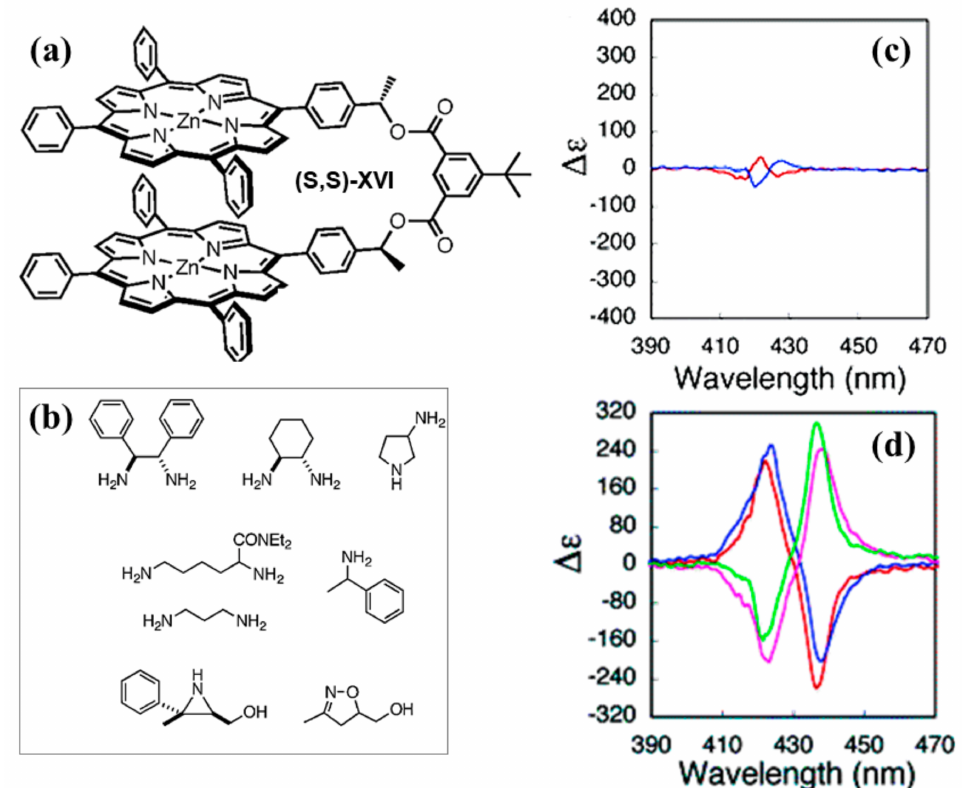
Figure 13. ( a ) Structure of the chiral bis-porphyrin XVI (reported the S, S-enantiomer); ( b ) Molecular structures of diamine, isooxazoline, and aziridines; ( c ) CD spectra of the bis-porphyrin enantiomer pairs ( R, R-, red curve, S, S-, blue curve); ( d ) CD spectra of (R, R)-Zinc(II)- XVI in the presence of ( i ) (R)- (red curve) and (S)-cyclohexane diamine (pink curve), and those of (S, S)-Zinc(II)- XVI in the presence of ( i ) (R)- (blue curve) and (S)-cyclohexane diamine (green curve). Adapted with permission from reference [72]; published by American Chemical Society